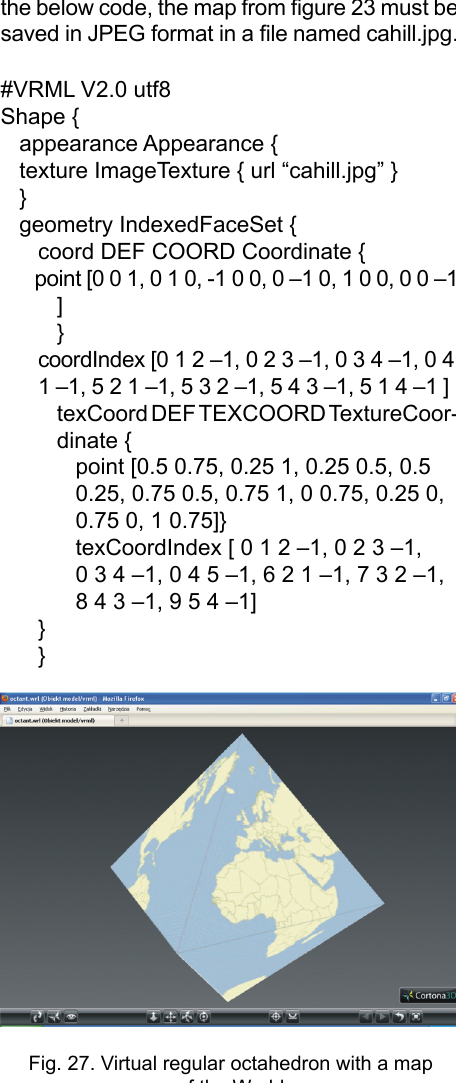
Fig. 26. Virtual globes in VRML